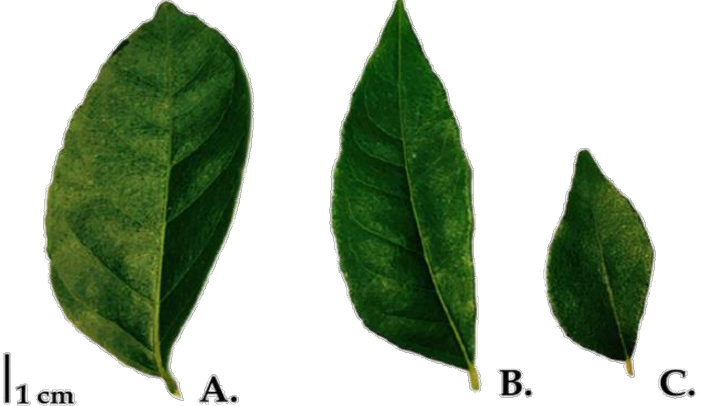
Figure 5. Representative leaf images of three plant species in Claseneae; ( A ) PSRU_RUT005-006, ( B ) PSRU_RUT003-004 and ( C ) PSRU_RUT001-002.